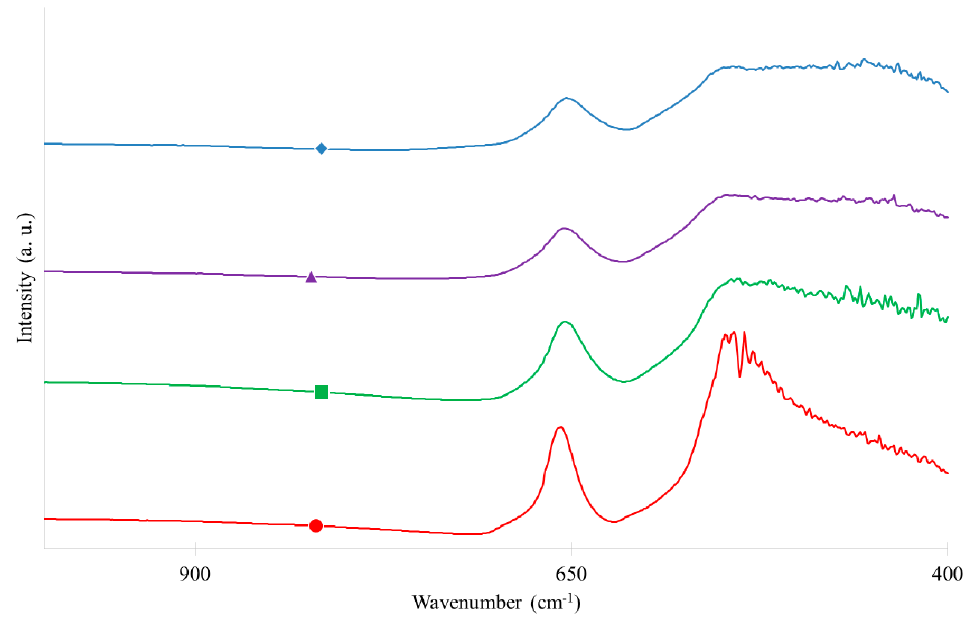
Figure 5. Fourier-transformed infrared spectroscopy (FTIR) spectra of ( ● ) pure ZnCo 2 O 4 , ( ■ ) ZnCo 2 O 4 /SnO 2 -10%, ( ▲ ) ZnCo 2 O 4 /SnO 2 -20% and ( ♦ ) ZnCo 2 O 4 /SnO 2 -30%.